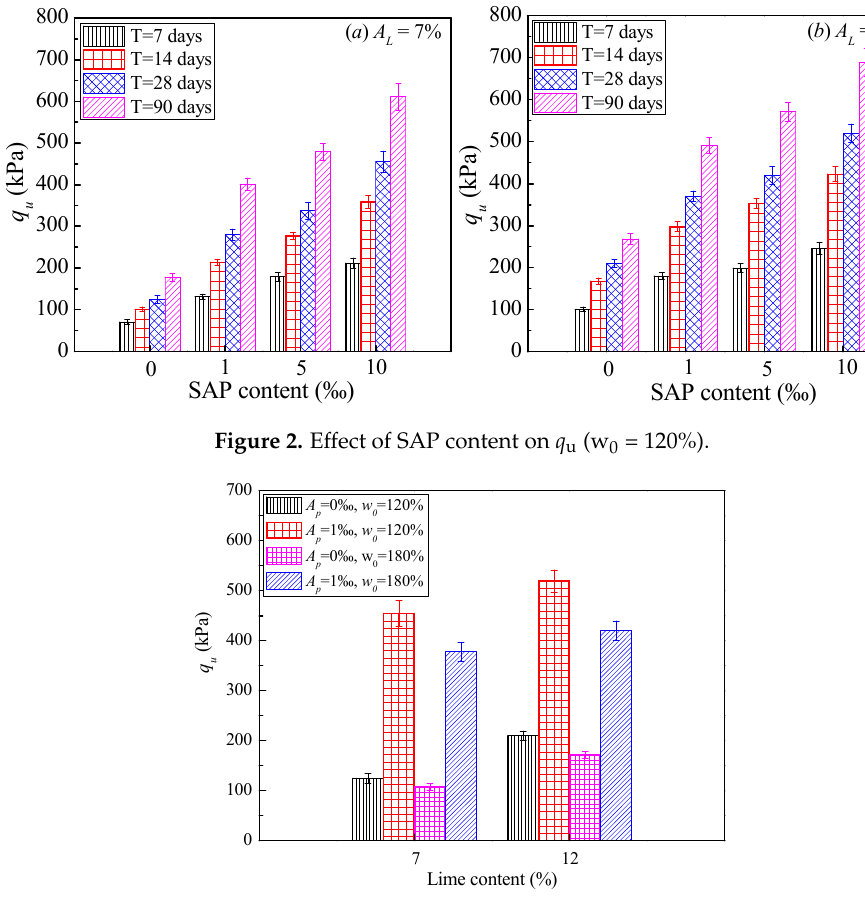
Figure 3. Effect of lime content on q u (curing of 28 days).